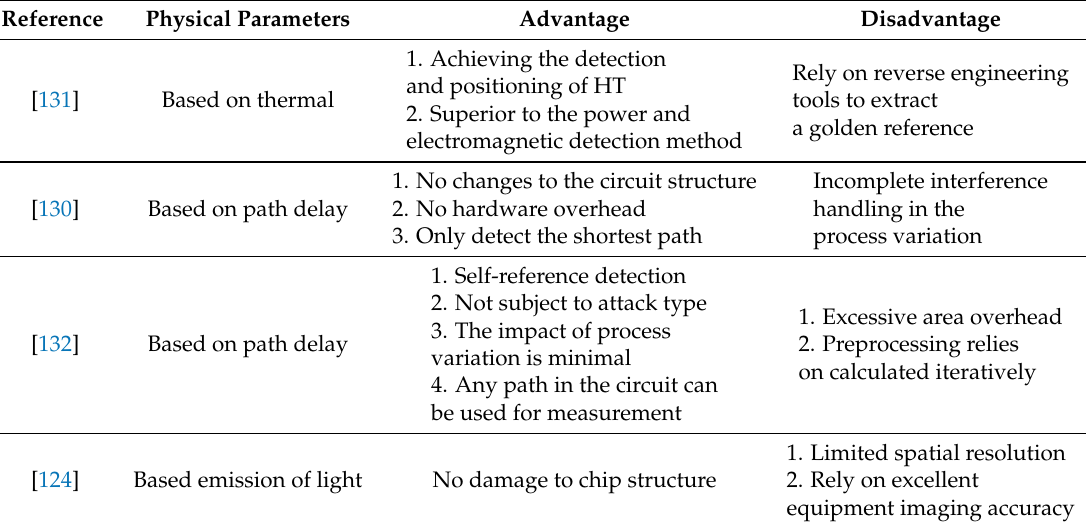
Table 2. Comparison for physical parameters in Side-channel signal